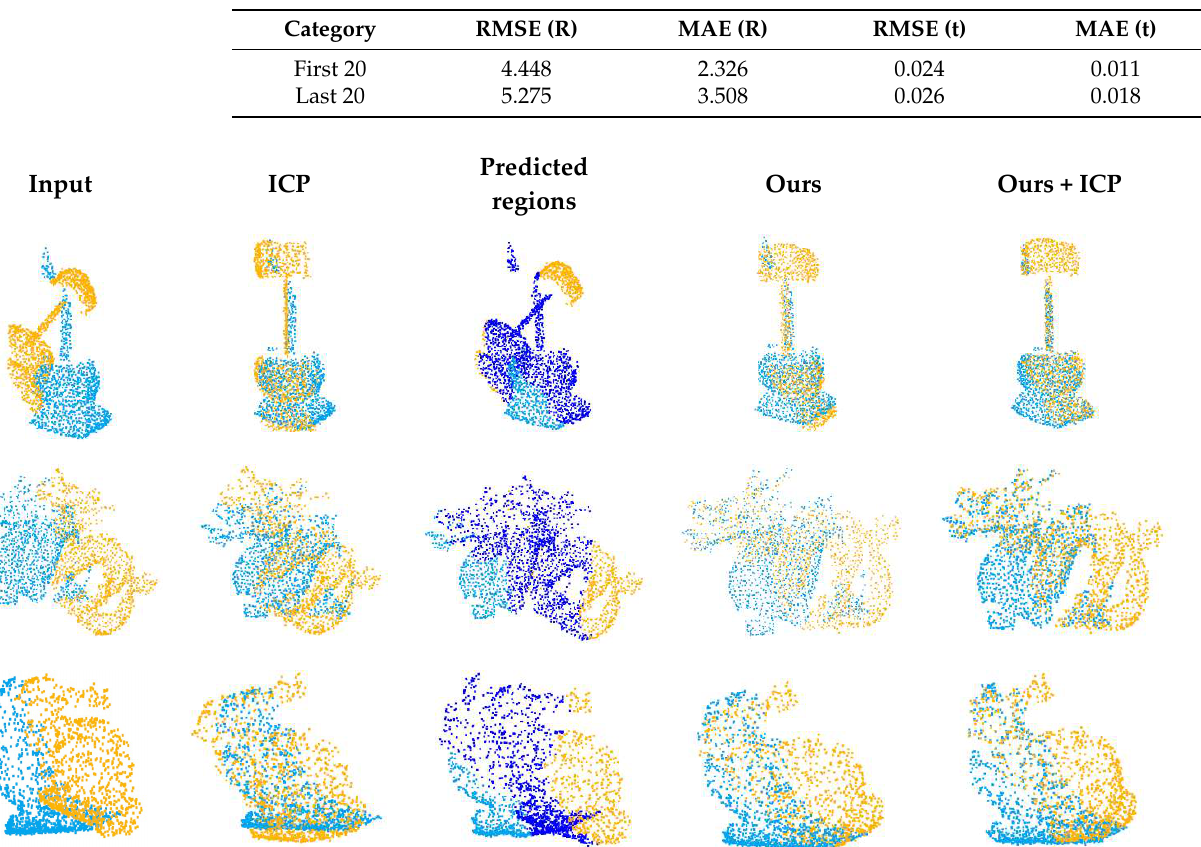
Table 3. Results of tests on point clouds of unseen categories in ModelNet40.